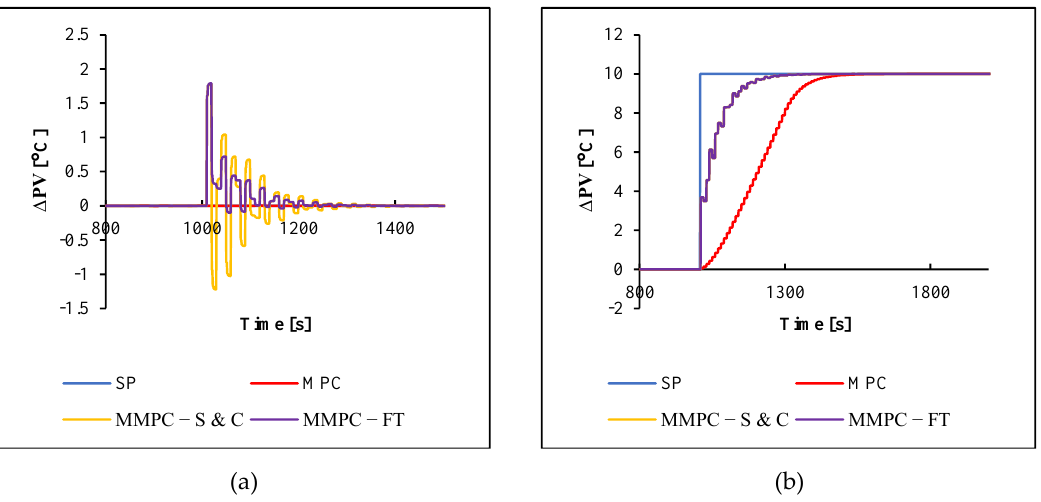
Figure 12. Comparison of controller performance with SP change on the combustor on: ( a ) the heater and ( b ) the combustor with SP change. Table 16. Comparison of IAE and ISE on the heater and combustor units due to changes in SP on the combustor